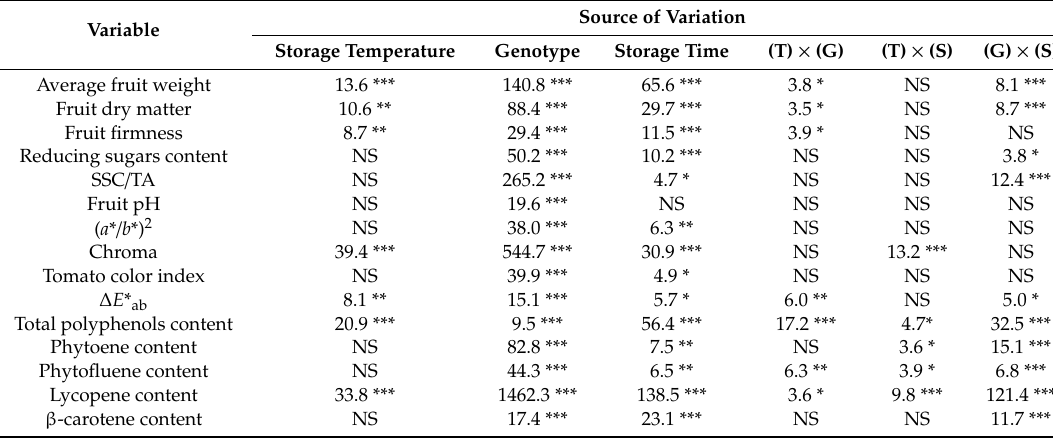
Table 2. F -test values of the main factors and their first order interactions related to observed variables, with the significance resulting from the analysis of